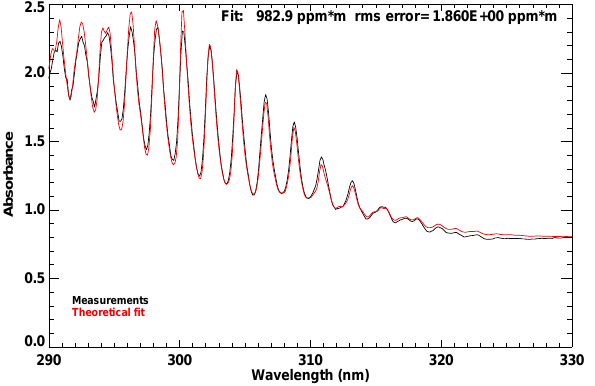
Fig. 4. Spectrometer measurements of the absorbance of UV light FIGURE 4. Spectrometer measurements of the absorbance of UV light through a quartz cell containing through a quartz cell containing SO 2 gas. The red line shows the SO 2 gas. The red line shows the theoretical variation of the absorbance with wavelength, based on the theoretical variation of the absorbance with wavelength, based on absorption coefficient data of Vandalae et al. (1994). the absorption coefficient data of Vandaele et al. (1994).